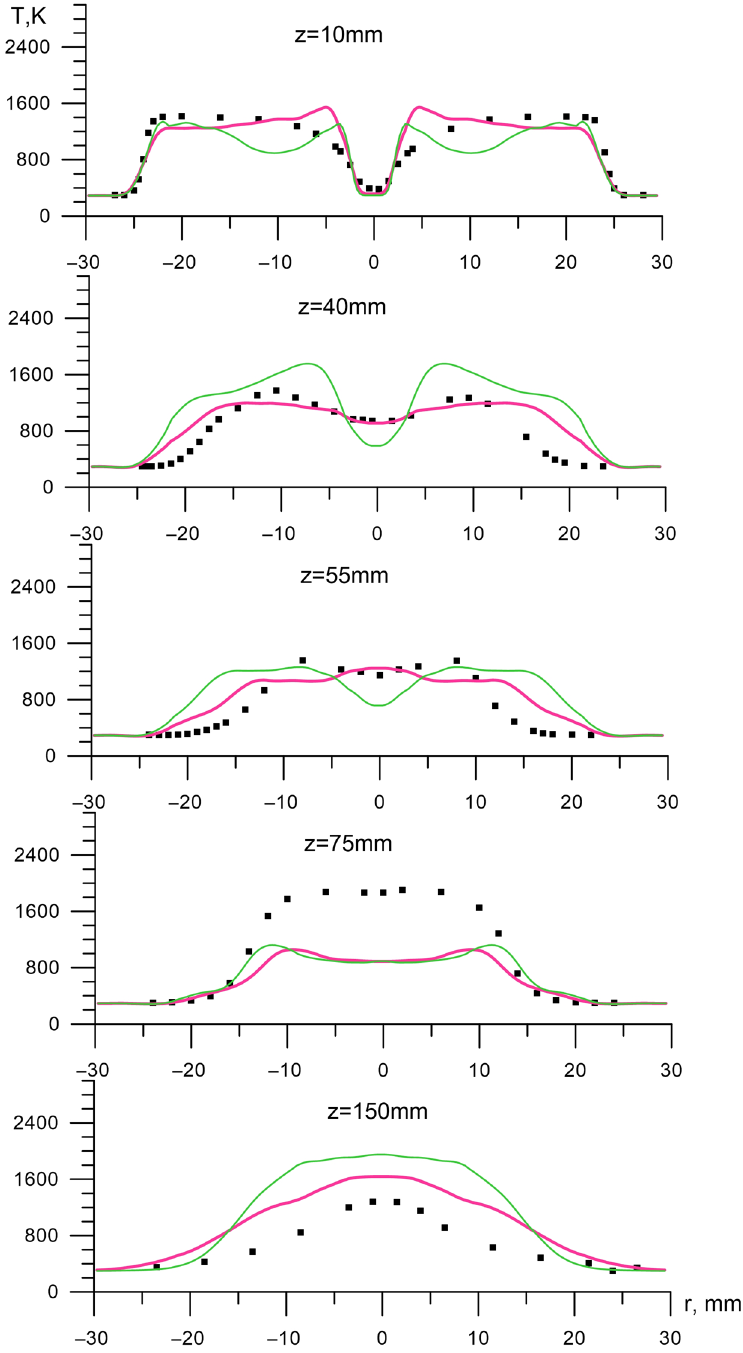
Figure 12. Comparison of the average temperature profiles with different kinetics. The green line denotes the simulation with Zhou kinetics; thick pink line denotes the simulation with BFER2 kinetics. All simulations were based on the Smagorinsky model.